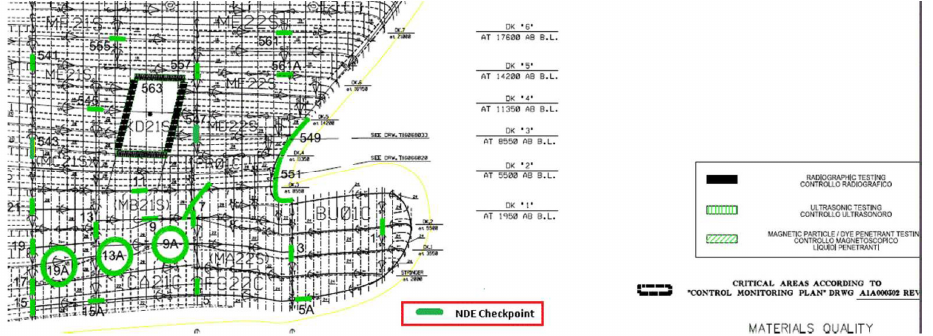
Figure 11. A typical NDT inspection plan